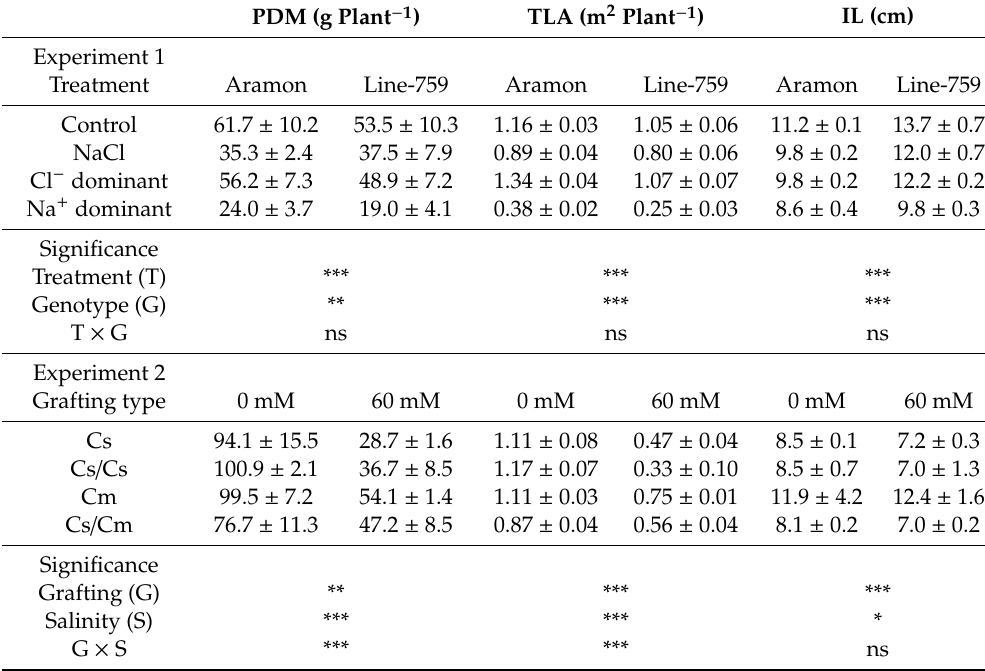
Table 2. E ff ects of mixed-salt (expt1) and grafting (expt2) on plant dry mass (PDM), total leaf area (TLA), and internode length (IL, average of ranks 6–15) in experiments 1 and